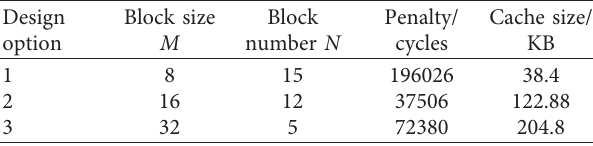
Table 2: Design option of three best choices.